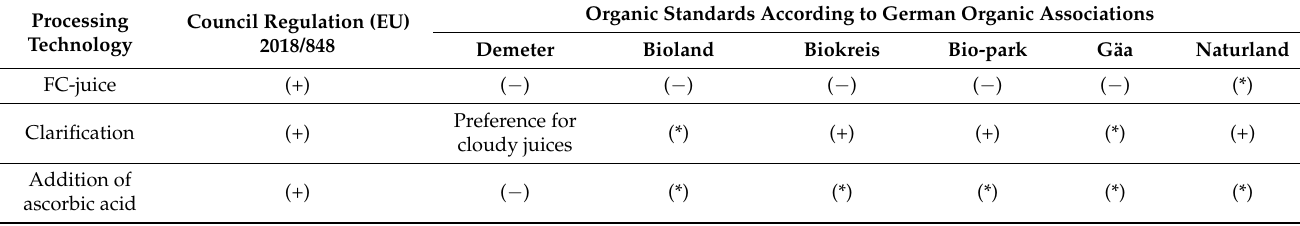
Table 2. Overview of organic standards for juice